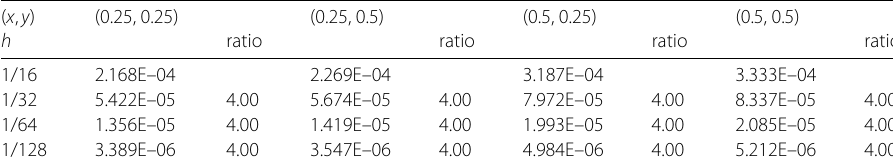
Table 6 The errors for finite difference solutions in the sense of pointwise